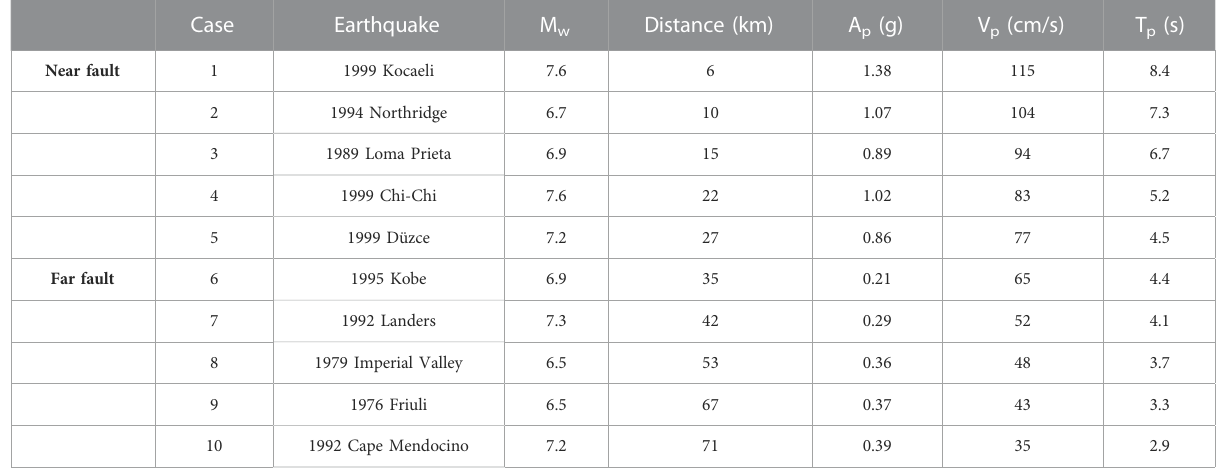
TABLE 2 Mechanical properties of a shake table (Cavuslu,